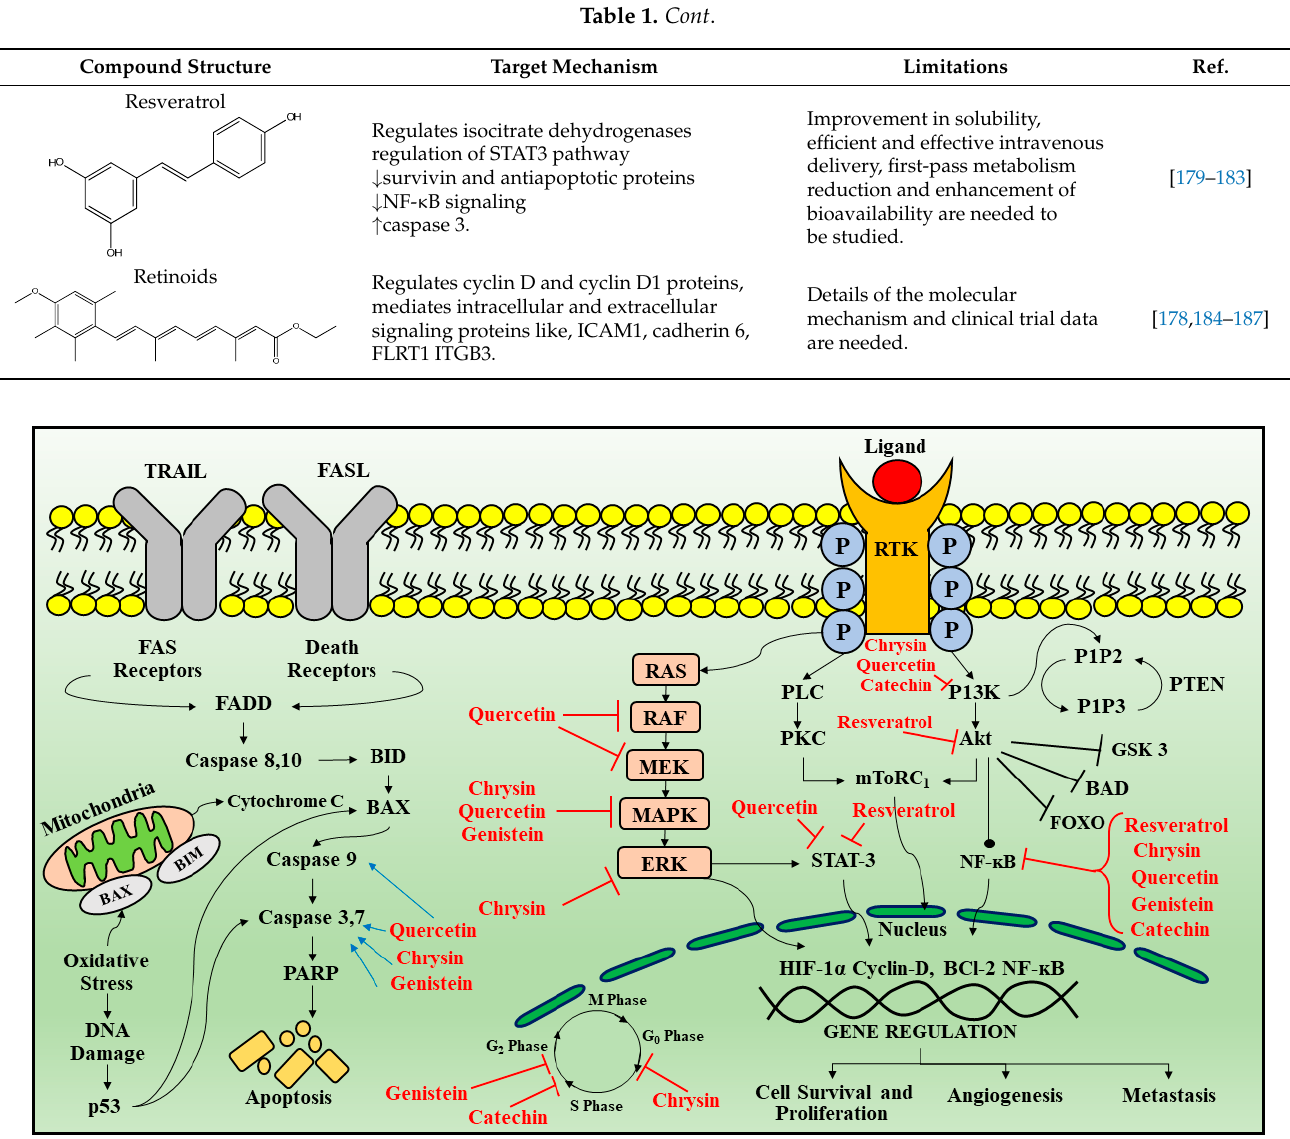
Figure 3. Signal transduction pathways targeted by phytoconstituents in glioblastoma. Apoptotic pathways are regulated by death receptor ligands (TRAIL and FAS). Once activated leads to the activation of FADD which further leads to the activation of caspase 8, 10, that targets BID protein inducing BAX oligomerization and release of cytochrome C from mitochondria along with activation of caspase 3 and 7 causing apoptosis. Another protein that regulates apoptosis is p53 which activates BAX. Receptor tyrosine kinase is activated by ligand binding causing receptor dimerization and auto phosphorylation of the tyrosine kinase domain. This results in activation of two main downstream signaling pathways: Ras/MAPK/ERK and PI3K/AKT. As these receptors activate downstream signaling cascade that participates in cell survival proliferation, angiogenesis and metastasis. Red arrows indicate inhibition and blue arrows indicate activation by phytoconstituents. Legend: TRAIL—Tumor necrosis factor-related apoptosis-inducing ligand; FADD—Fas-associated death domain; BID—B cell lymphoma-2-interacting domain; PARP—Poly (ADP-ribose) polymerase; EGF—endothelial